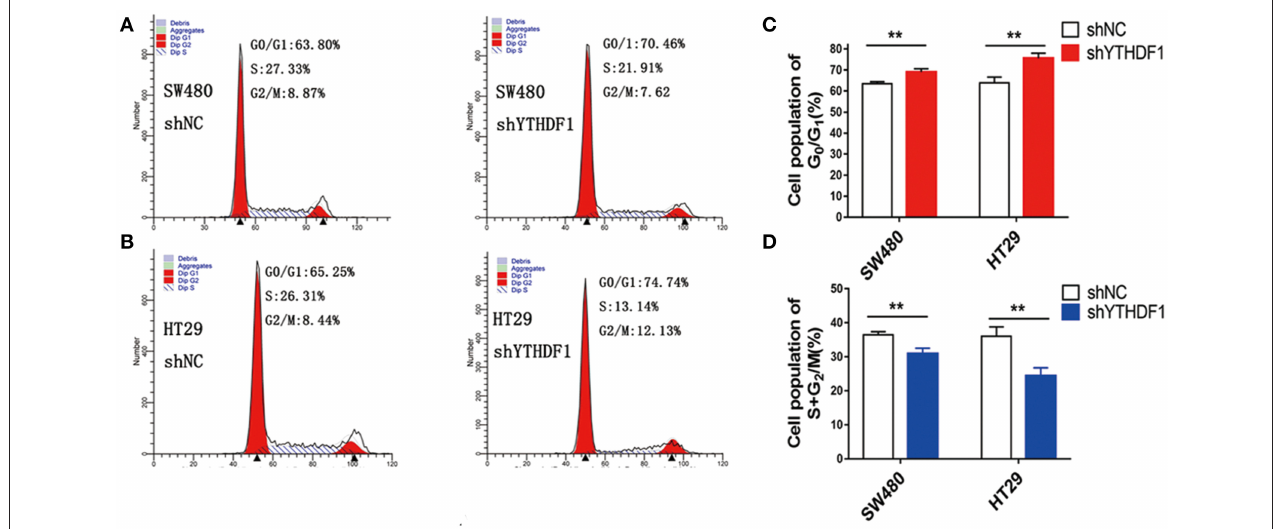
FIGURE 4 | YTHDF1 promotes the cell cycle progression of CRC cell by flow cytometry analysis. Knockdown of YTHDF1 increased the G0/G1 phase fraction and decreased the S-phase fraction. (A) SW480 cells with shNC transfection (left panel), with shYTHDF1 transfection, (B) HT29 cells with shNC transfection (left panel), with shYTHDF1 transfection. (C) The statistics of SW480 cells with shNC or shYTHDF1 transfection. (D) The statistics of HT29 cells with shNC or shYTHDF1 transfection. (** p <